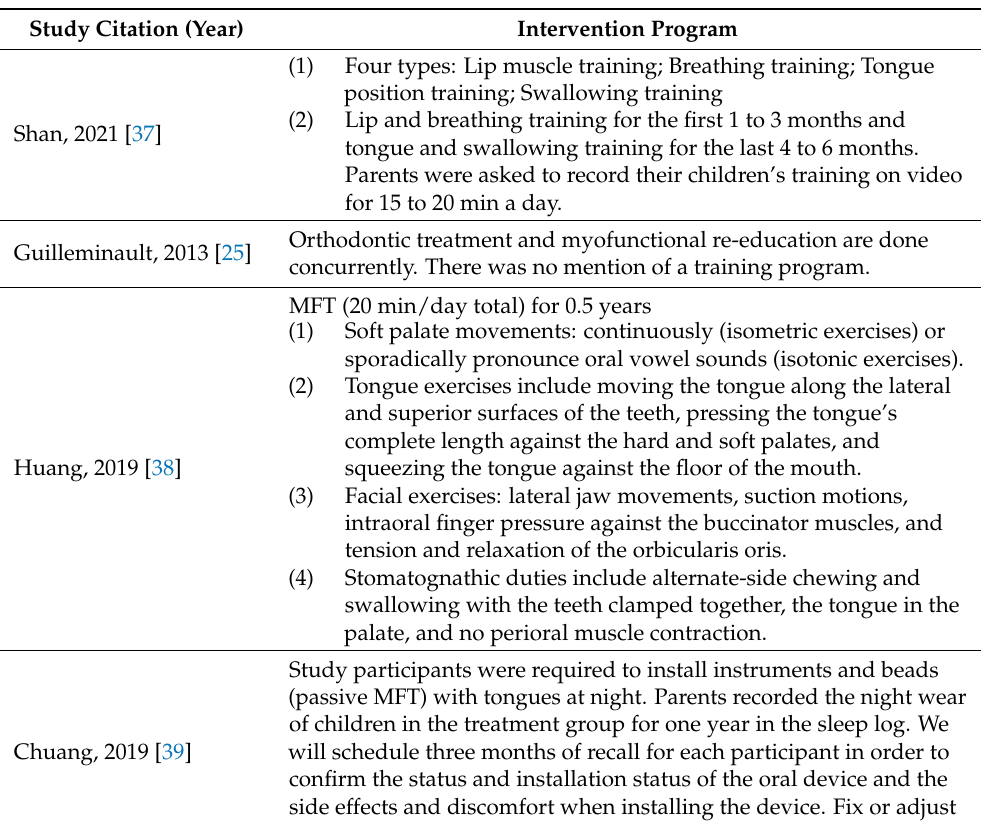
Table 5. OMT intervention